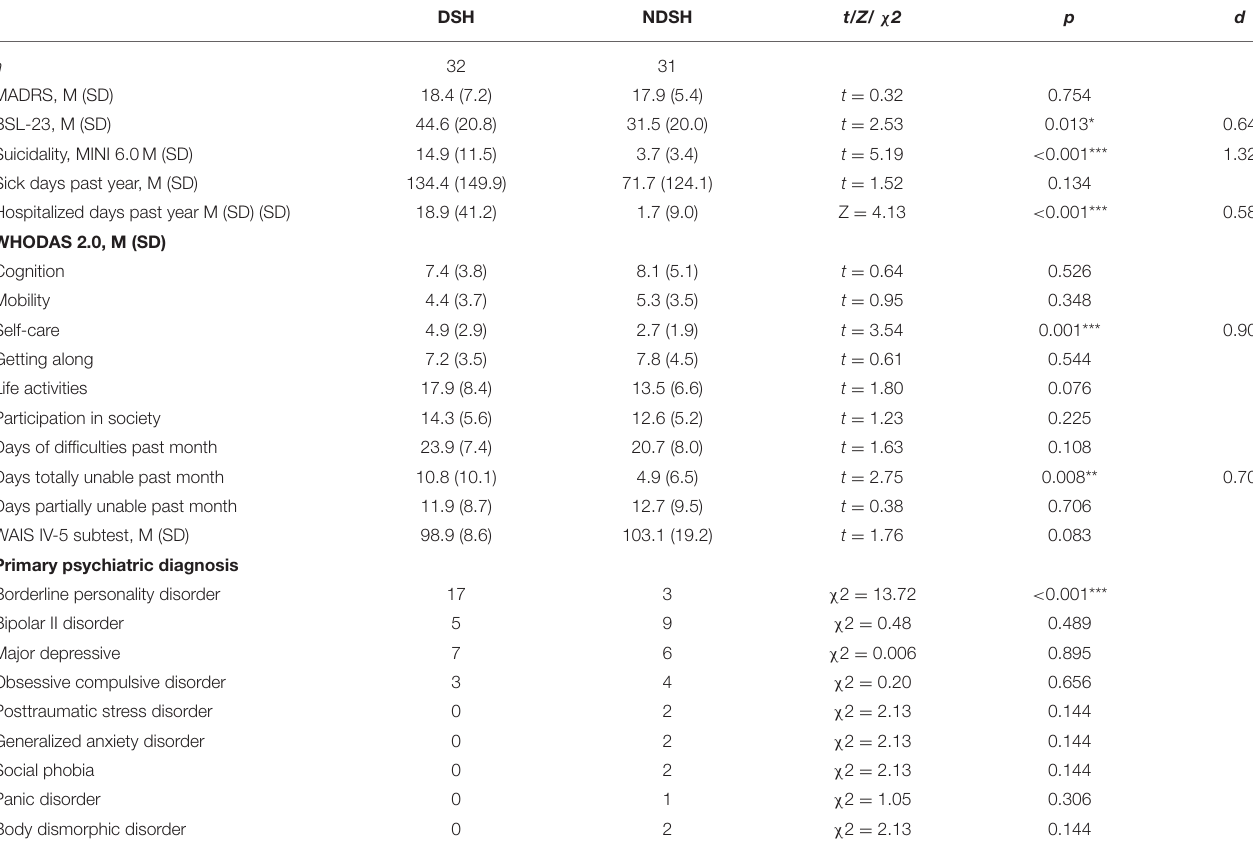
TABLE 2 | Distribution of diagnoses and results for measures of psychopathology, functioning measures and general cognitive functioning level. DSH